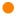
Schematic representation of the architecture of myelinated fibers in the peripheral nervous system (PNS). The three layers of connectives tissues are depicted and three myelinated fibers are enlarged. The first fiber (bottom) represents a rolled Schwann cell (SC). The second fiber (middle) shows a longitudinal section of a Schwann cell. The third fiber (top), is a view of Schwann cell unrolled. Axonal (orange ) and basal lamina (blue ) cell adhesion molecules (CAMs) and Linker of Nucleoskeleton and Cytoskeleton complex (LINC; purple ) are represented. Actin filaments are depicted with purple thin lines. SLI: Schmidt-Lanterman incisures.